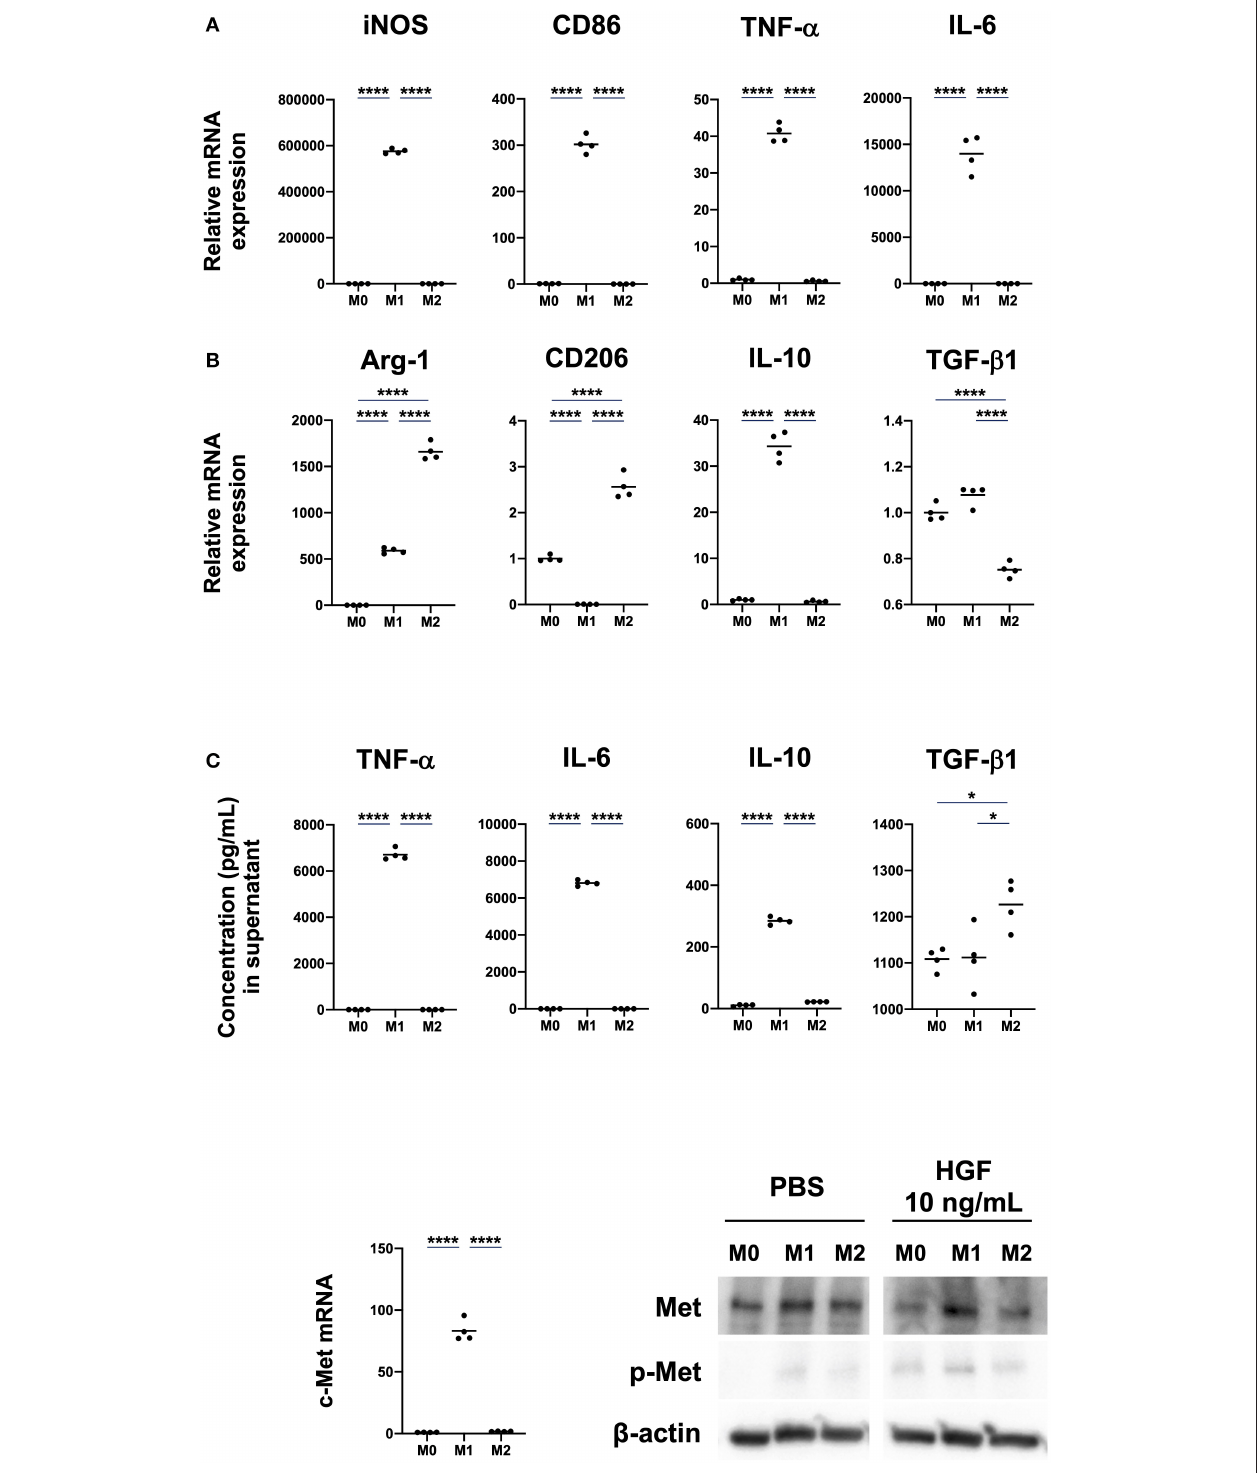
FIGURE 1 | M1 macrophages induced by IFN- γ and LPS treatment show enhanced expression and phosphorylation of c-Met. (A) Expression of M1 and M2 markers. Bone marrow-derived macrophages (BMDMs; M0 macrophages) were differentiated by treatment of bone-marrow cells with M-CSF (25ng/mL) for 7 days. Macrophages were polarized to M1 and M2 phenotypes by treatment for 48h with IFN- γ and LPS or IL-4, respectively. Total RNA extraction and RT-qPCR were used to analyze mRNA expression of the M1 markers iNOS , CD86 , TNF- α , and IL-6 and M2 markers Arg-1 , CD206 , IL-10 , and TGF- β 1 . (B) Concentrations of cytokines in cell culture supernatant. ELISA was used to measure spontaneous secretion of TNF- α , IL-6, IL-10, and TGF- β 1 in cell culture supernatant from M0, M1, and M2